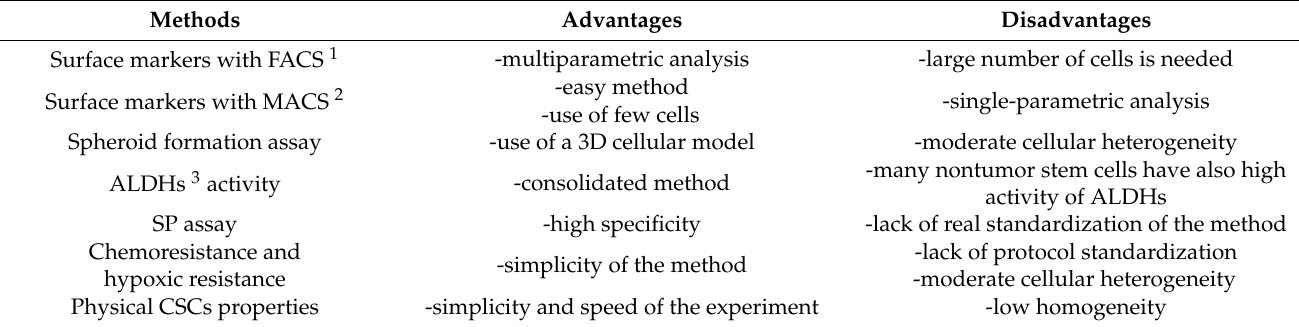
Table 1. Advantages and disadvantages of the different methods for the study of CSCs.